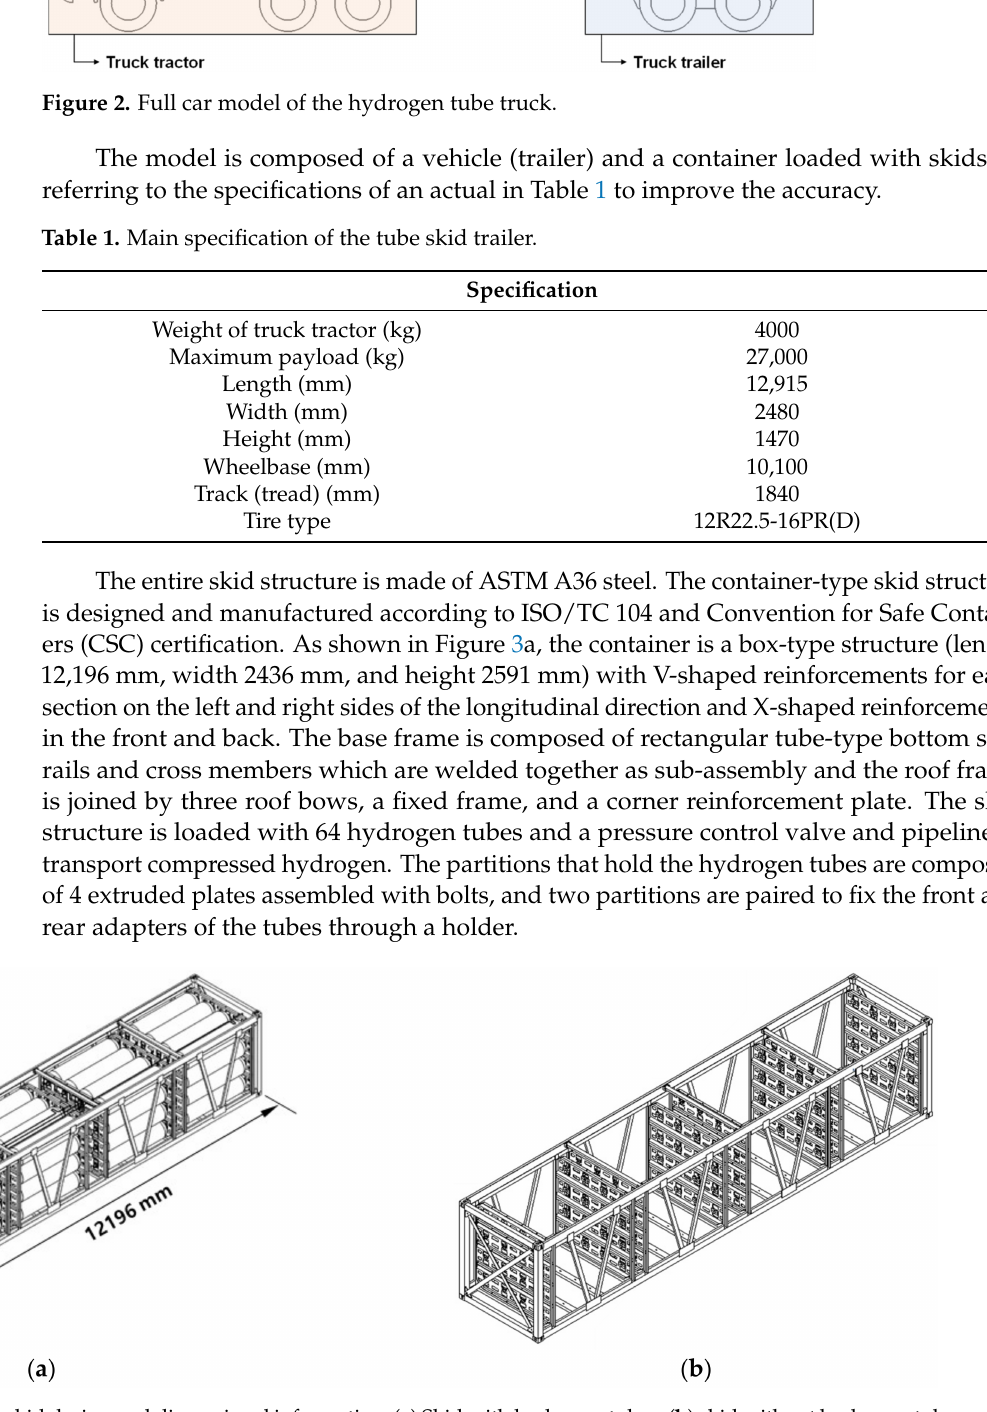
Figure 3. Simplified tube skid design and dimensional information, ( a ) Skid with hydrogen tubes; ( b ) skid without hydrogen